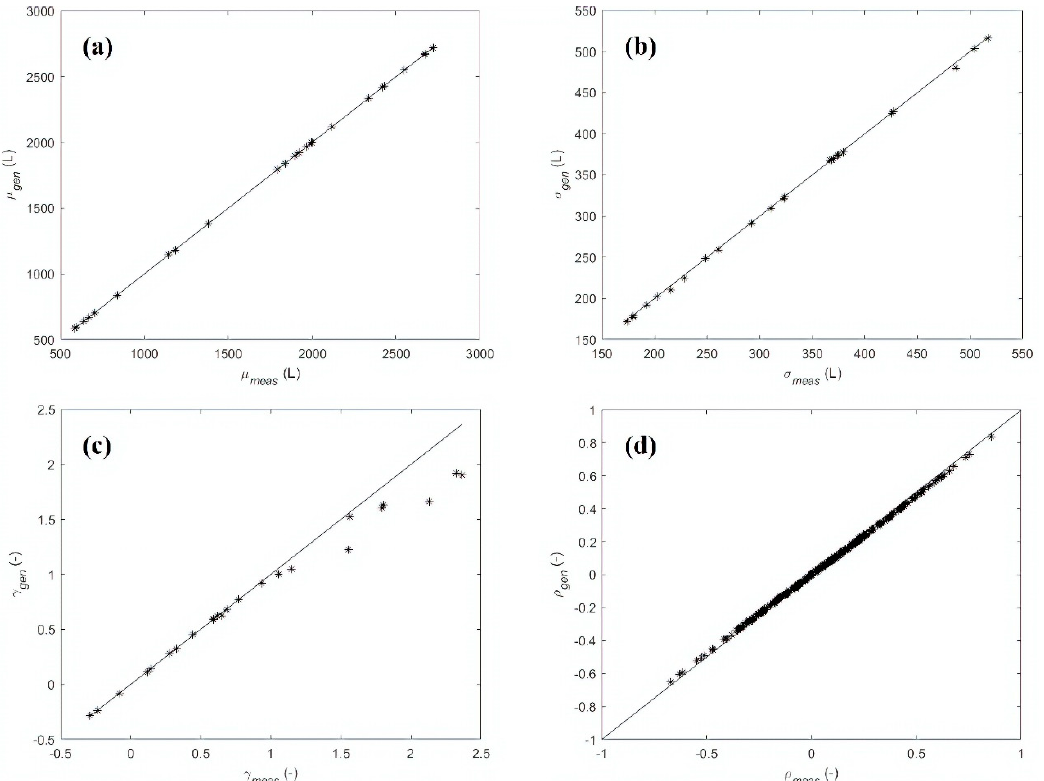
Figure 3. Case study 1 (Application 1)—Comparison between measured and generated aggregated hourly demands: ( a ) mean values µ , ( b ) standard deviation values σ , ( c ) skewness γ , ( d ) rank cross-correlations ρ .